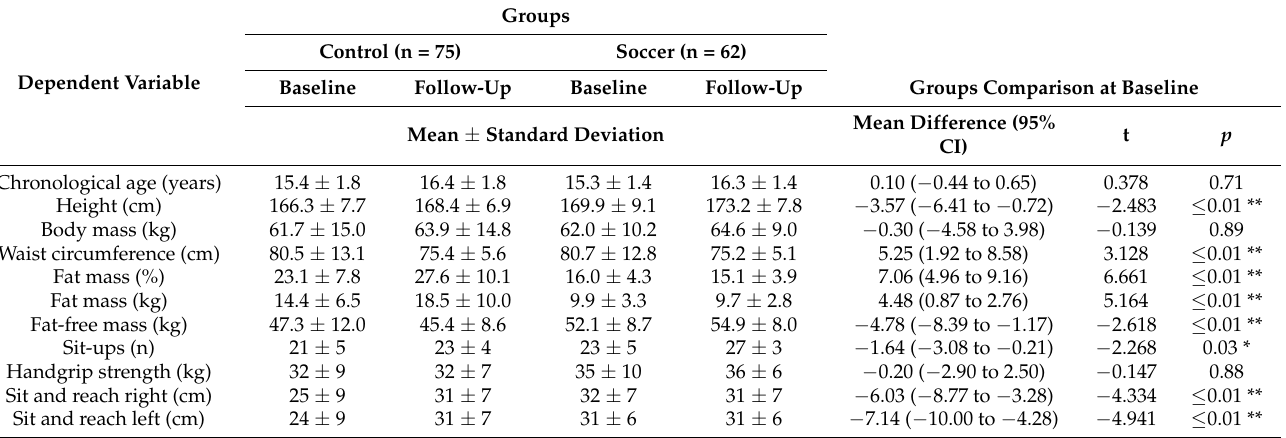
Table 1. Descriptive statistics for each group at baseline and follow-up, and comparison between groups at